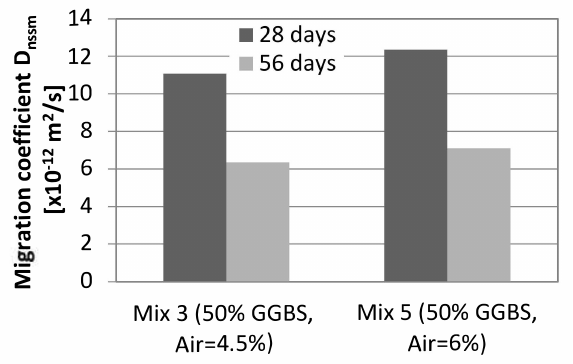
Figure 14. Rapid chloride migration coe ffi cient, DRCM, for mixes with 50% GGBS, k = 0.6 and di ff erent amount of air, cured at 20 ◦